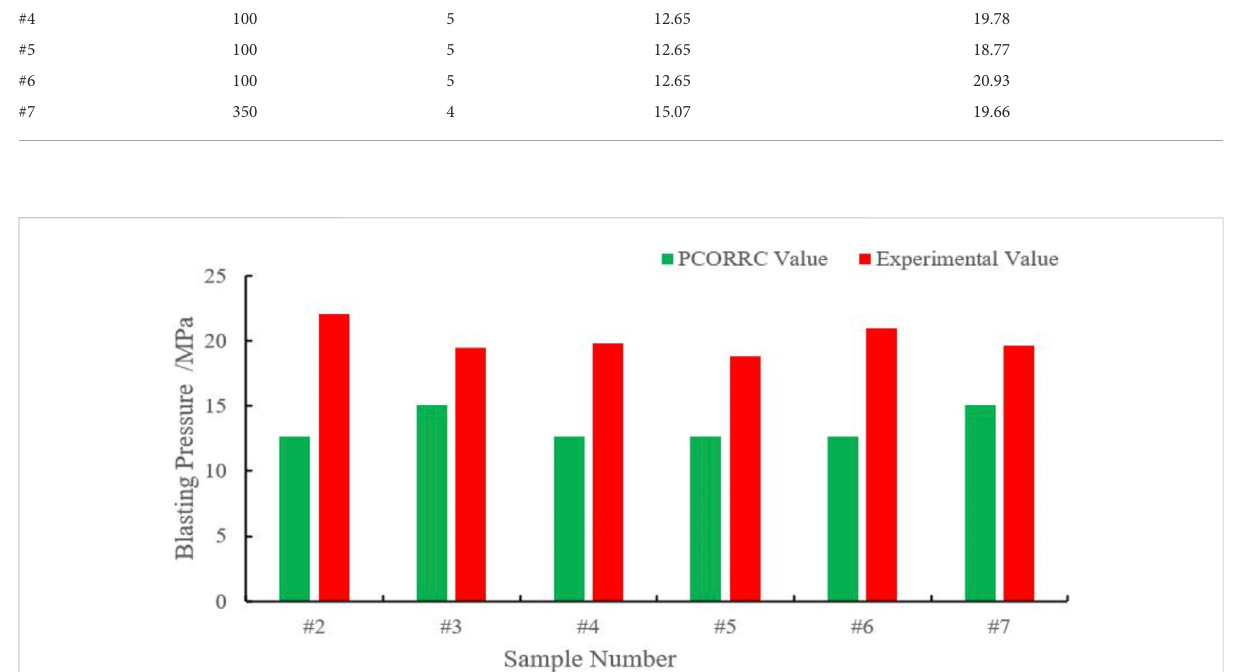
FIGURE 14 Comparisons between PCORRC and experimental